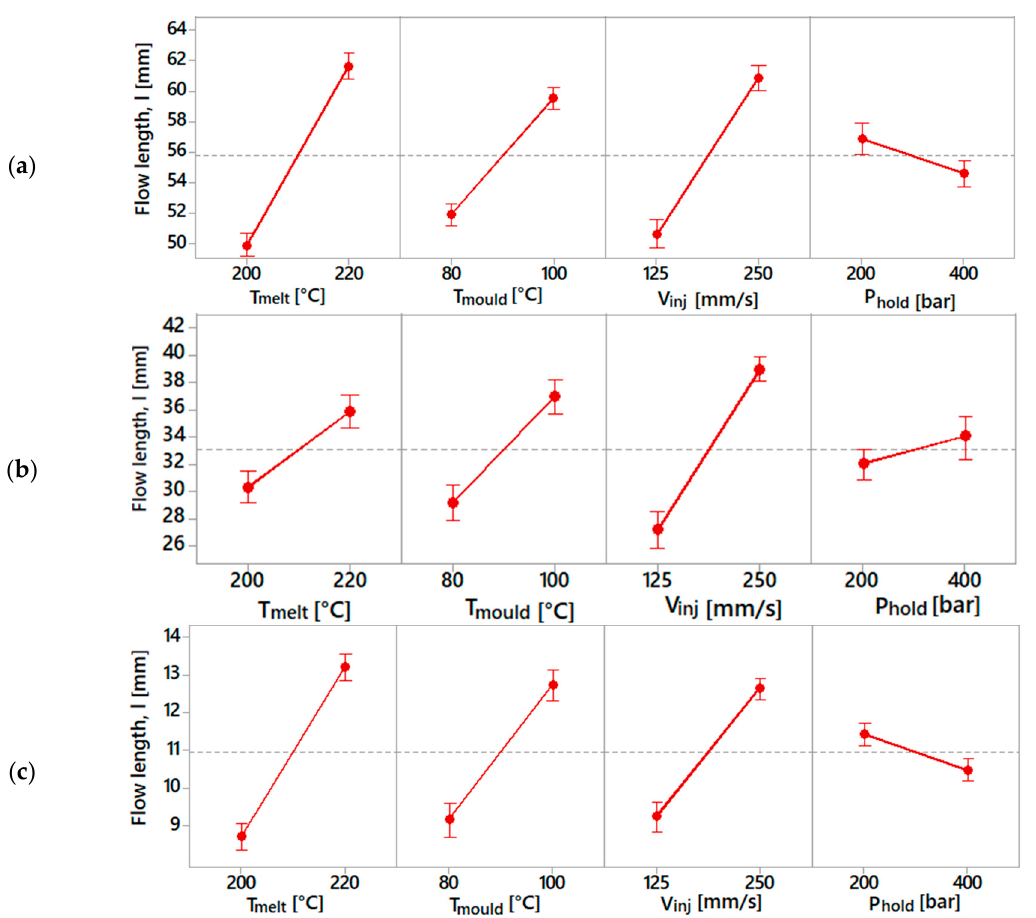
Figure 7. Main effect plot for spiral geometries with ( a ) 1 × 1 mm 2 , ( b ) 0.5 × 0.5 mm 2 and ( c ) 0.25 × 0.25 mm 2 cross sections.